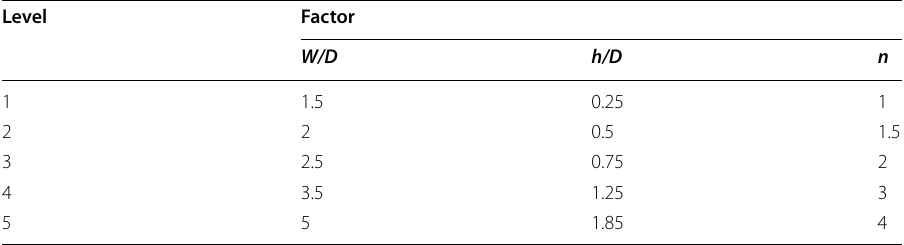
Table 1 Factors and levels in the experiment Level